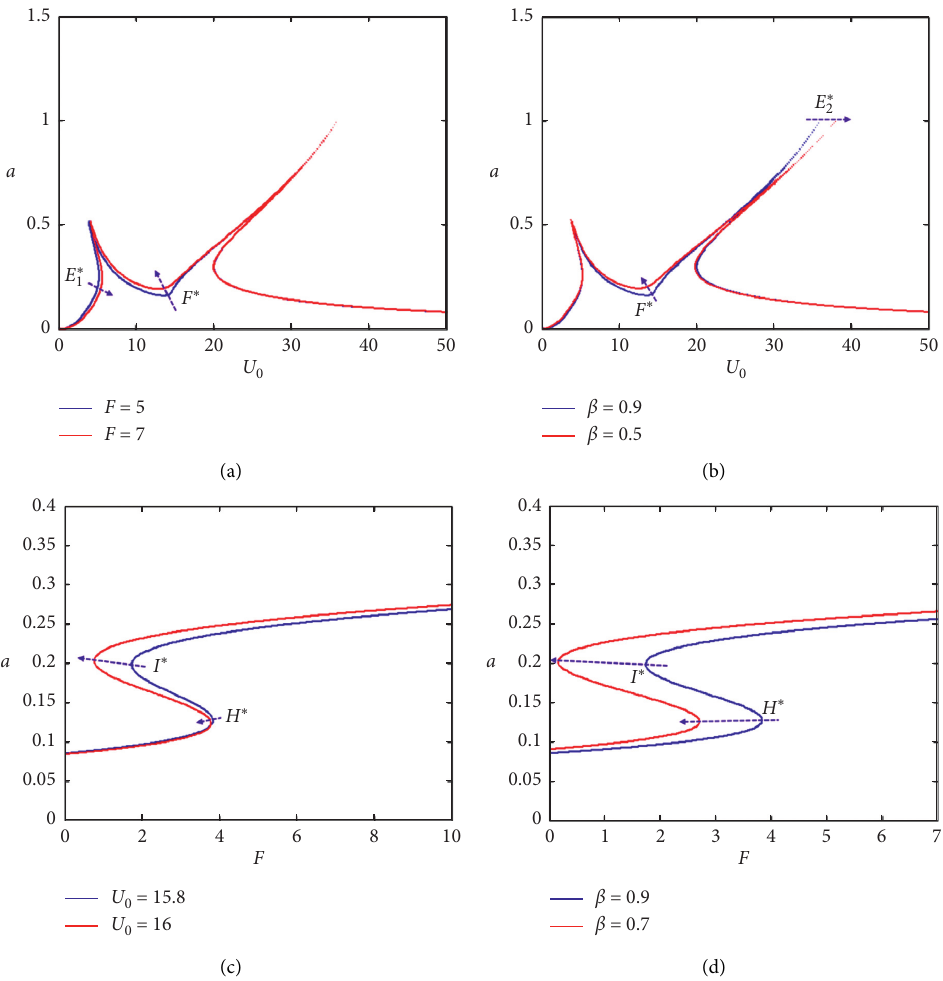
Figure 6: The influences of different parameters on the amplitude-frequency response curves and force-amplitude response curves are given for the cantilevered pipe conveying pulsating fluid. (a) Amplitude-frequency response curves on flow velocity when F � 5 and F � 7, (b) amplitude- frequencyresponse curves onflow velocity when mass parameters β � 0 . 9 and β � 0 . 5, (c) force-amplituderesponse curves onexternal force when � 15 . 8 and U � 16, and (d) force-amplitude response curves on external force when mass parameters β � 0 . 9 and β � 0 . flow velocities U 0 0